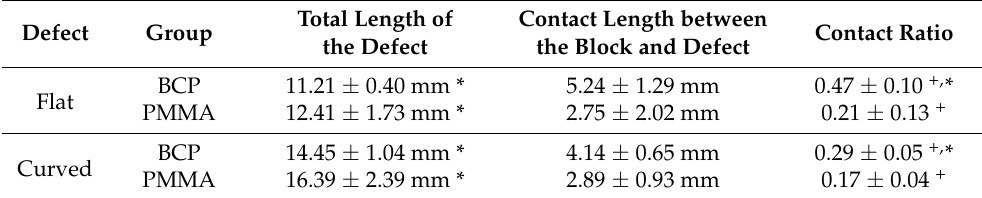
Table 1. The ratio of internal contact between the block and defect measured in the cross-sectional scanning electron microscope